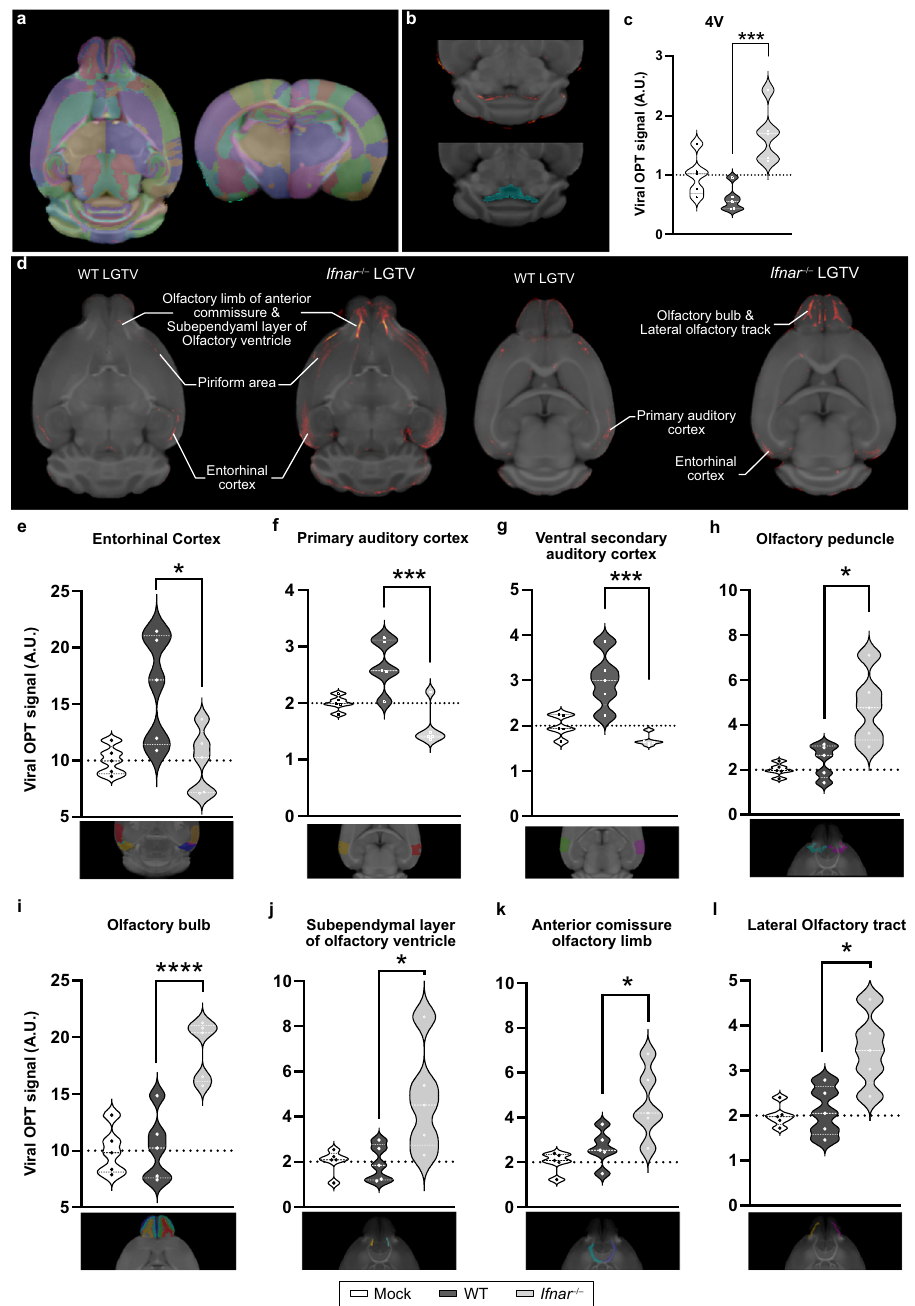
Fig. 3|Imaging andquanti fi cationofviralinfectionrevealedashiftininfected regions shaped by the IFN-I response. a Axial and coronal representation of the OCUMbraintemplatewithitsaccordingatlas 21 . b TypicalexampleofanOPT-OCUM fusion displaying signal in the fourth ventricle (upper panel) and the VOI delinea- tionbasedontheOCUM-atlas(lowerpanel). c Quanti fi cationandstatisticalanalysis (two-tailed unpaired t-test) ofviralOPTsignalin fourth ventricle of WT and Ifnar – / – mice. Allvalues werenormalized to the mockgroup and areexpressed inarbitrary